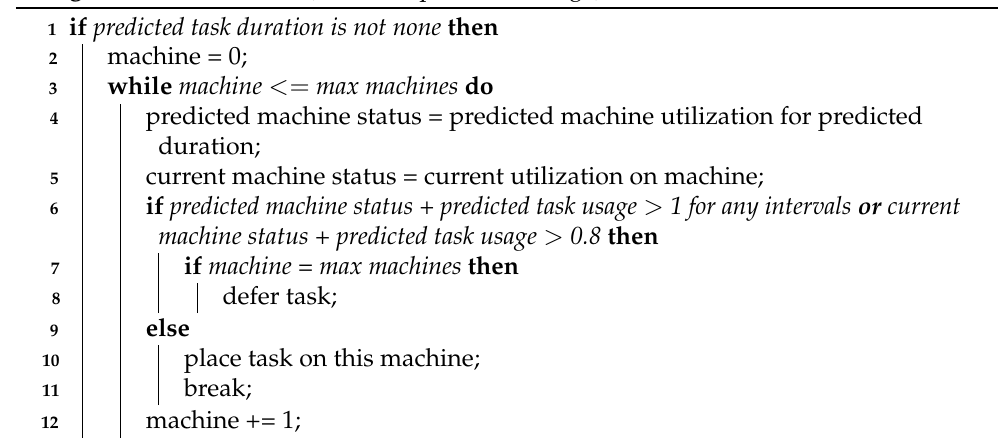
Algorithm 3: Place task (based on predicted usage) in N-CP-A scheduler.